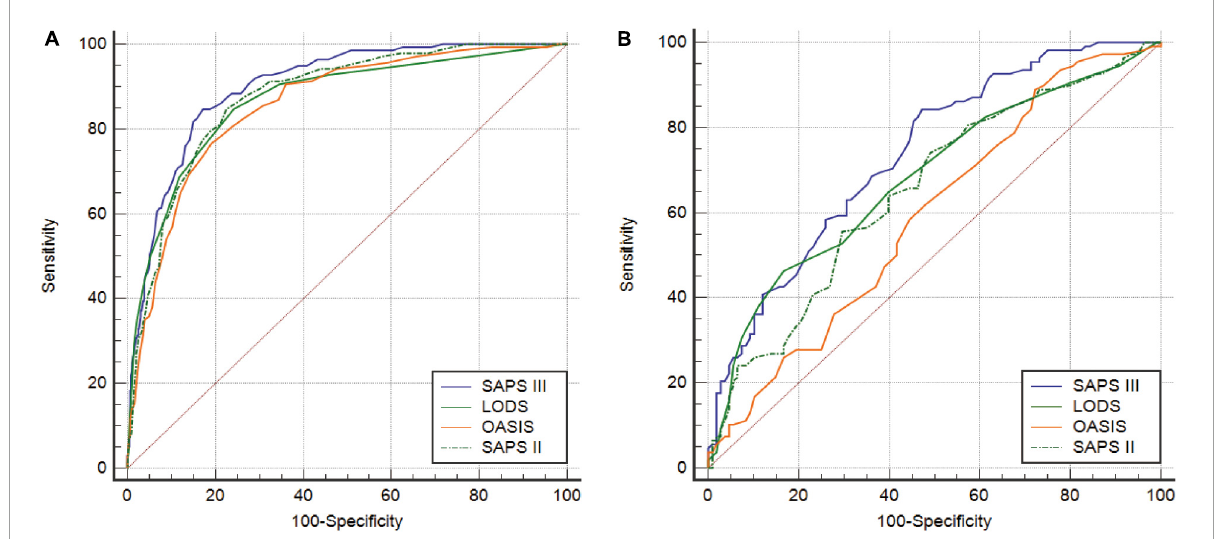
FIGURE2 (A) ROC curves of LODS, OASIS, SAPS II, and SAPS III before PSM. (B) ROC curves of LODS, OASIS, SAPS II, and SAPS III after PSM. ROC, receiver operating characteristic; LODS, logistic organ dysfunction system; OASIS, oxford acute severity of illness score; SAPS, simplified acute physiology score; PSM, propensity score matching.